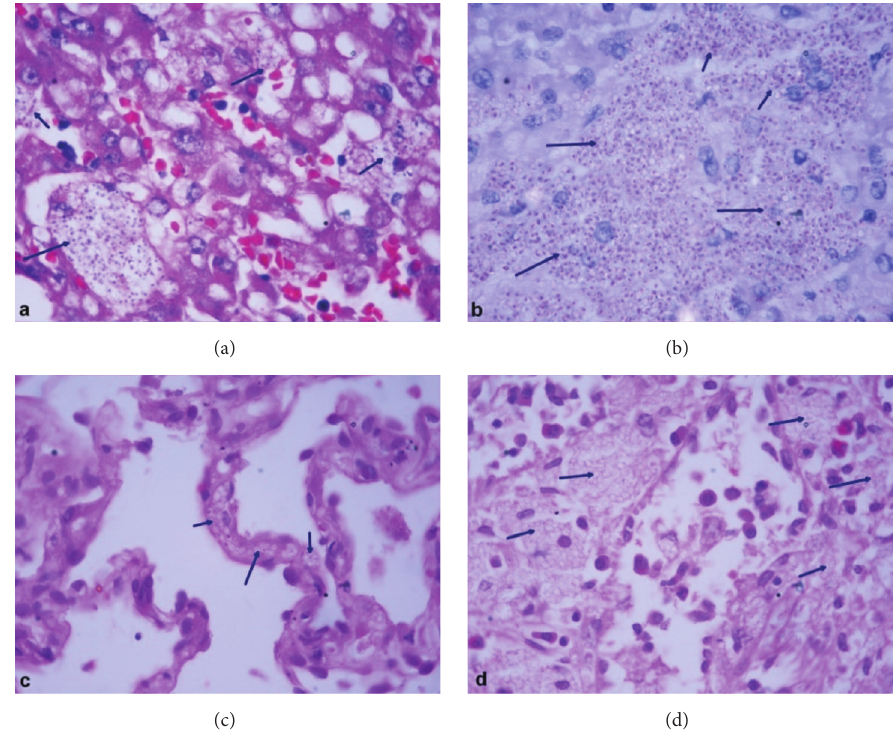
Figure 3: Liver biopsy shows numerous spherical organisms in the sinusoidal macrophages and Kupffer cells, (a) H&E × 1000, which stained positive with periodic acid Schiff stain (b) × 1000. Similar organisms are also seen in interstitial histiocytes in lung, (c) H&E × 1000, and splenic macrophages, (d) H&E × 1000. All are morphologically compatible with Histoplasma as focused with